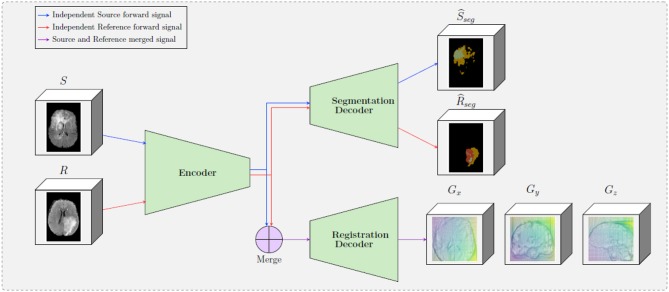
A schematic representation of the proposed framework. The framework is composed by two decoders, one which provides tumor segmentation masks for both S and R images, and one the provides the optimal displacement grid G that will accurately map the S to the R image. The merge bloc will combine the forward signal of the source input and the reference input (which are forwarded independently in the encoder).